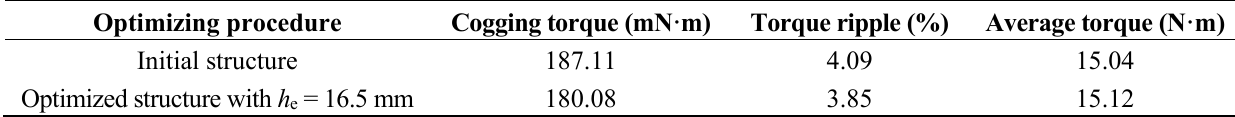
Table 4. Torque characteristics before and after the eccentric teeth optimization.